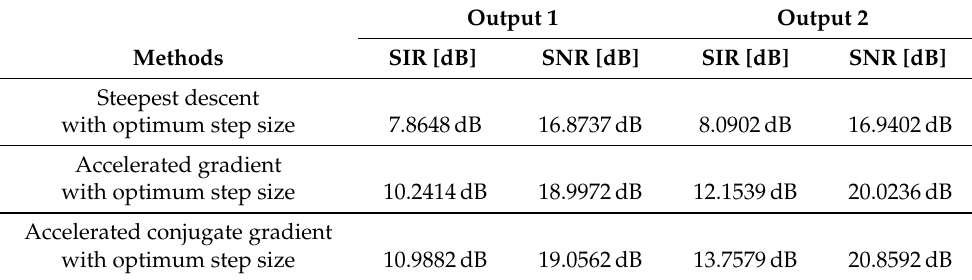
Table 2. Second order BSS in a simulated room environment with two speech sources, noise, and three microphones for the dominant speech output detected by the kurtosis. The SNR is